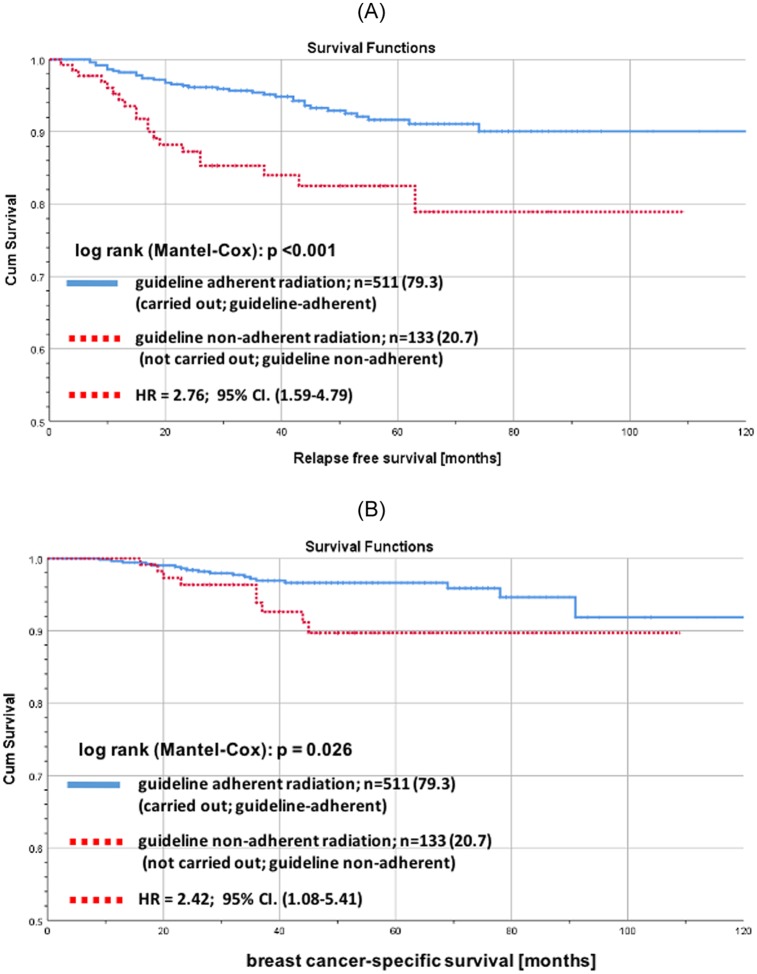
Recurrence free and tumor-associated overall survival for early breast cancer patients aged ≥ 70 years stratified by guideline adherent radiotherapy.(A) Kaplan-Meier curves of recurrence free survival for higher-risk early breast cancer patients aged 70 years or older with guideline adherent BCS stratified by guideline adherent RT. Higher-risk: other than luminal A or G3 or T3/T4 or node-positive. (B) Kaplan-Meier curves of tumor-associated overall survival for higher-risk early breast cancer patients aged 70 years or older with guideline adherent BCS stratified by guideline adherent RT. Higher-risk: other than luminal A or G3 or T3/T4 or node-positive.